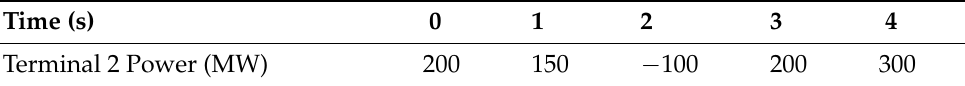
Table 3. Active power references for the slave terminals.